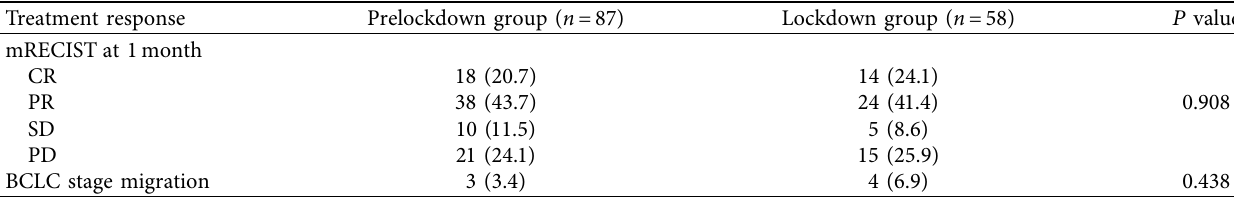
Table 4: Treatment response analysis at 1 month of prelockdown versus